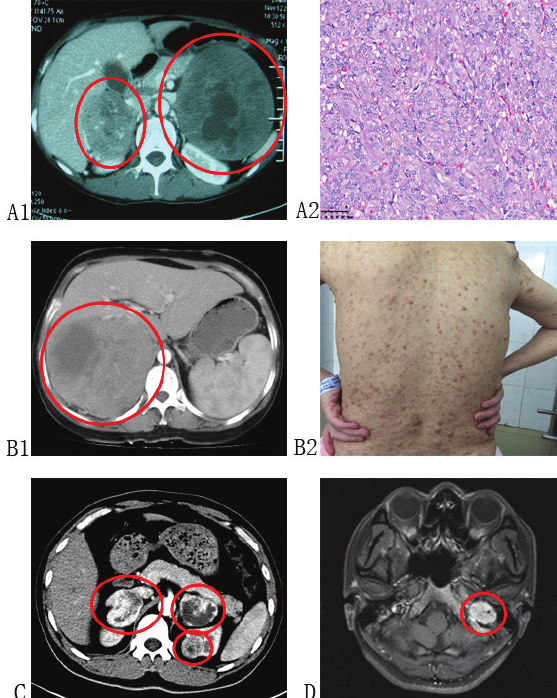
Figure 1. Clinical presentations of PCC/PGL-related syn- dromes. (A1 and A2): Patient diagnosed with MEN-2 pre- sented with bilateral PCC and MTC. (B1 and B2): Patient diagnosed with NF-1 presented with PCC of right adrenal and multiple neurofibromas on her body. (C): Patient di- agnosed with VHL presented with bilateral PCC and left ccRCC. (D): Patient diagnosed with FPGL presented with PGL in her left foramina jugulare, and genetic testing identi- fied germline SDHB mutation of her and her